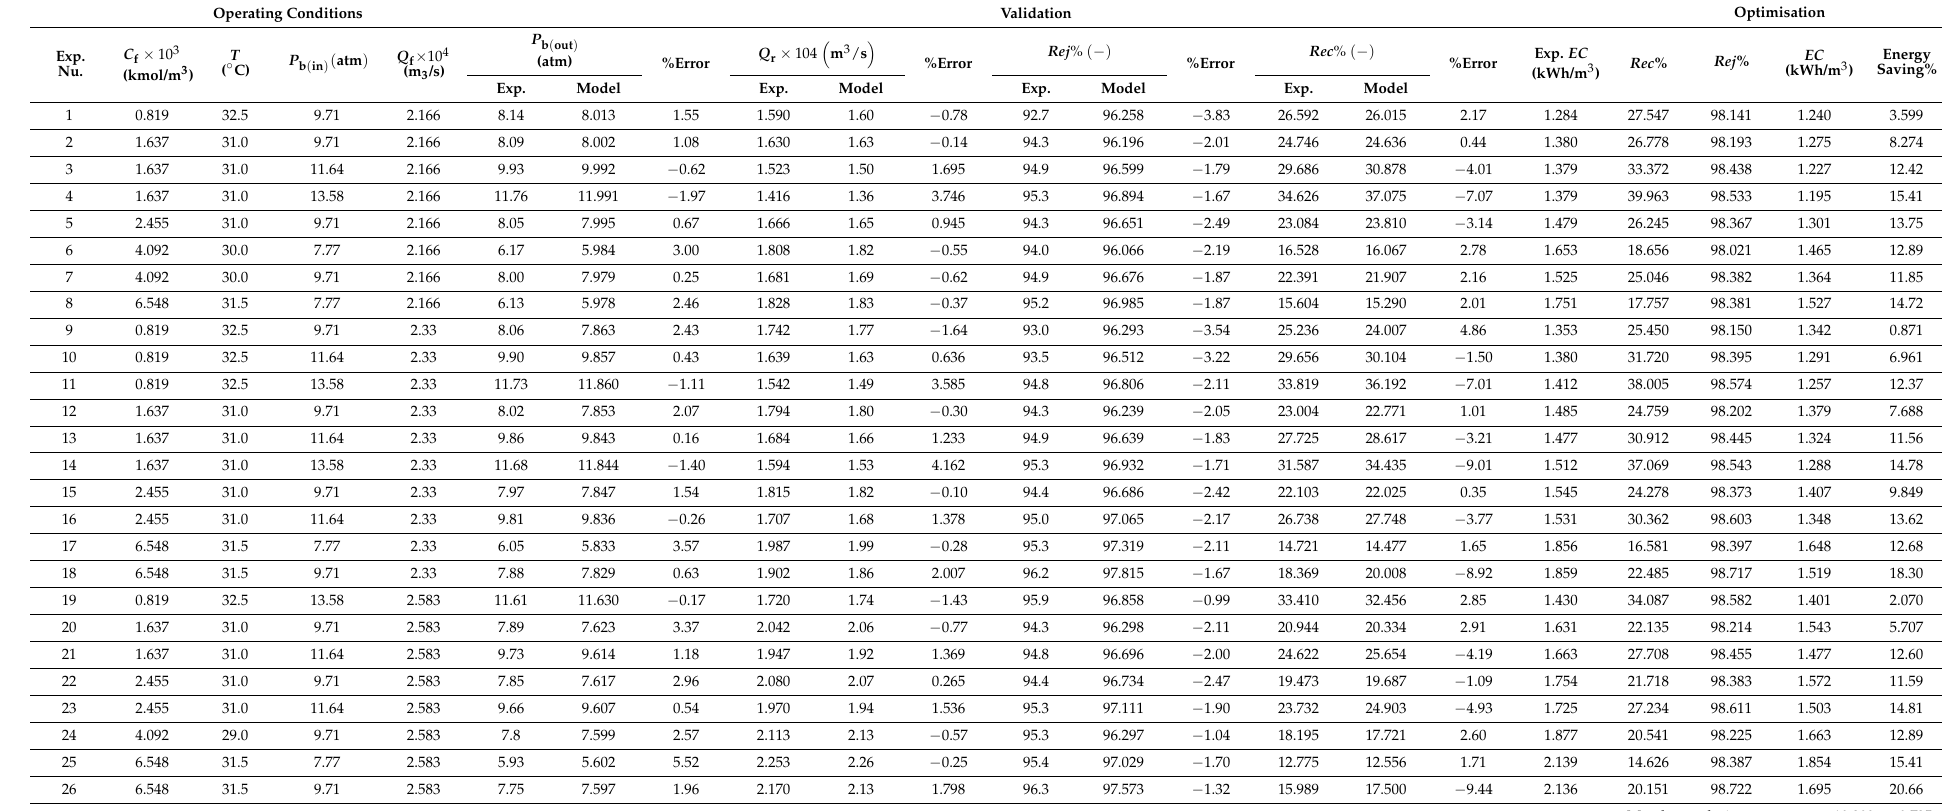
Membranedesignparameters: 0.934(m),8.4(m),and5 × 10 − 4 (m)ofmembranewidth,length,andfeedchannelheight,respectively